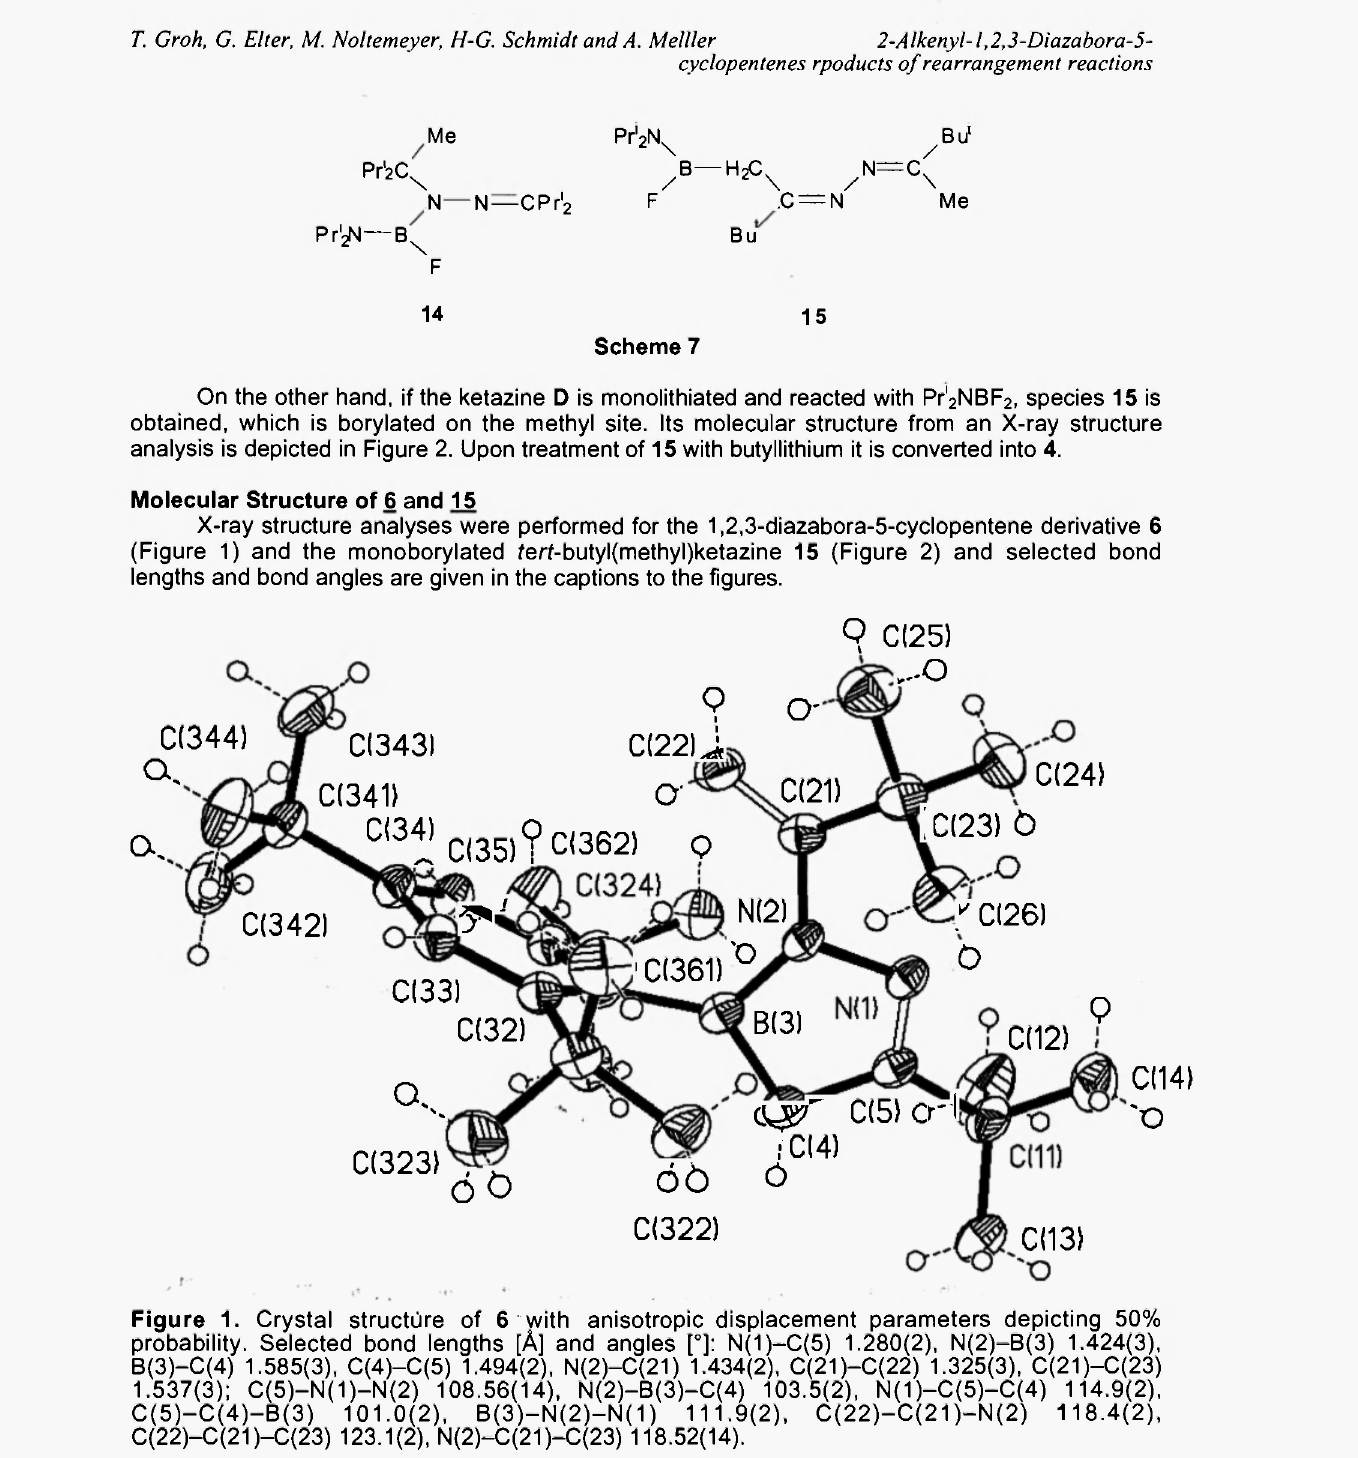
Figure 1. Crystal structüre of 6 with anisotropic displacement parameters depicting 50% probability. Selected bond lengths [Ä] and angles [°]: N(1)-C(5) 1.280(2), N(2)-B(3) 1.424(3), B(3)-C(4) 1.585(3), C(4)-C(5) 1.494(2), N(2)-C(21) 1.434(2), C(21)-C(22) 1.325(3), C(21)-C(23) 1.537(3);